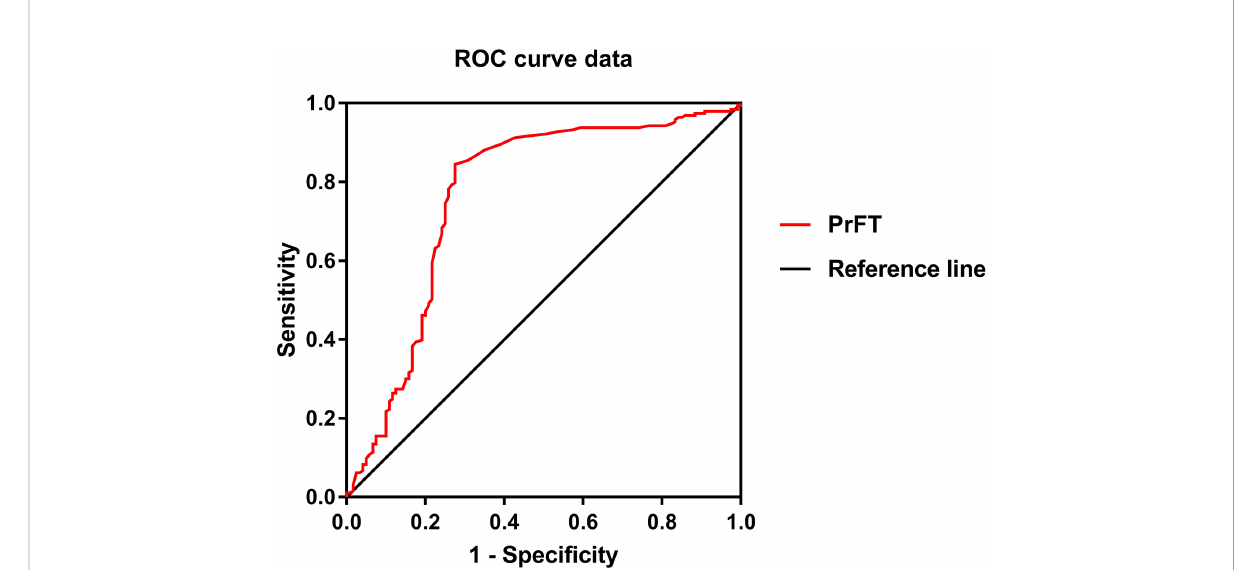
FIGURE 2 Receiver operating characteristic curves for the cutoff value of perirenal fat thickness (PrFT) to identify